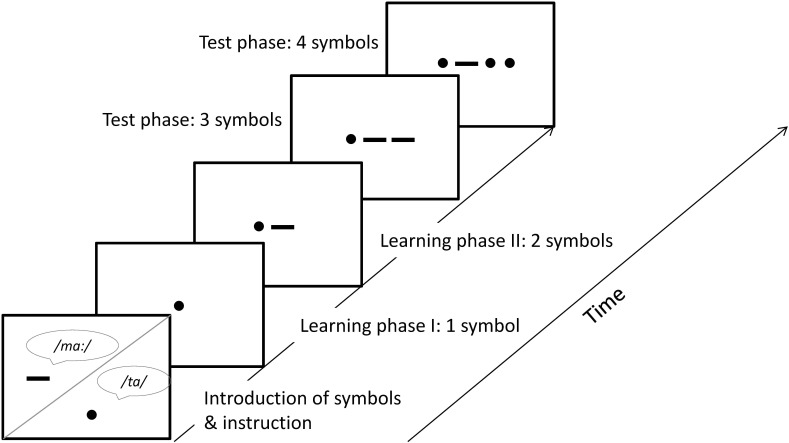
Task procedure of the sound-symbol paradigm (SSP; Horbach et al., 2015).